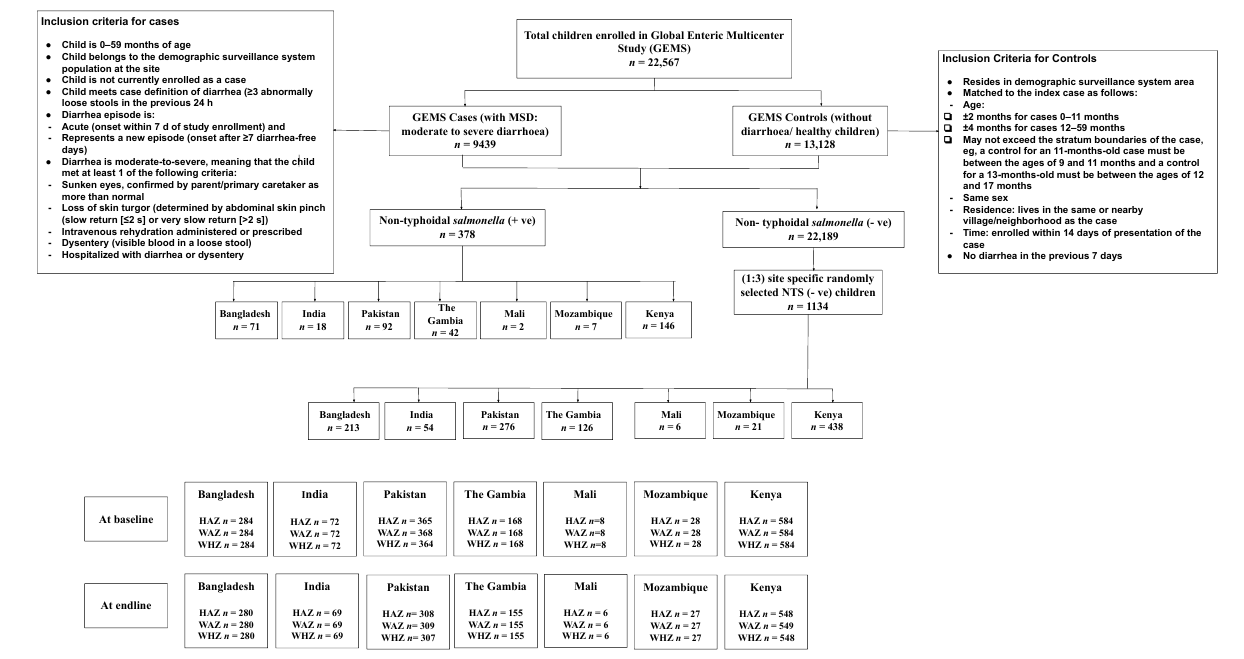
Figure 1. Study profile of enrolled